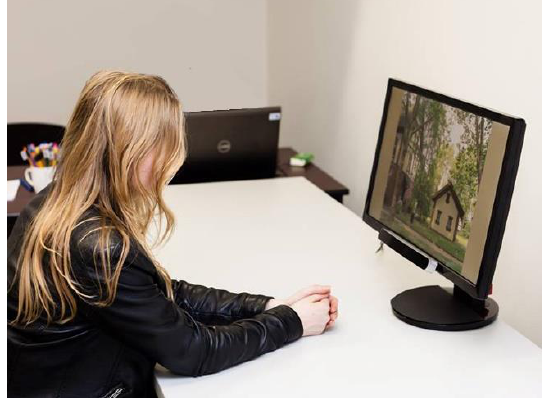
Figure 1. A student testing the functionality of a stationary eye tracker (photo from studies in 2017).